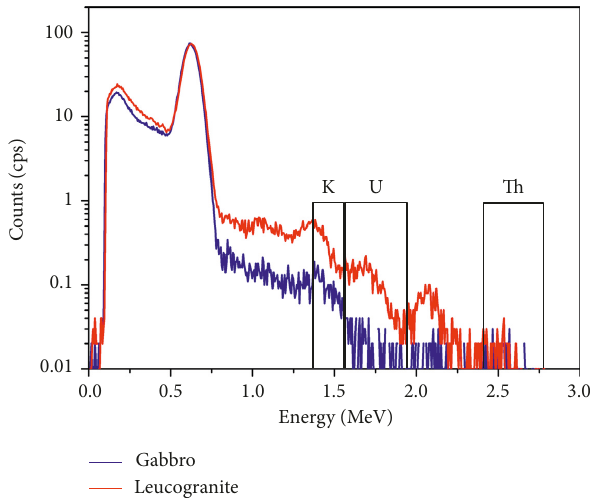
Figure 2: Example of two different field gamma spectrometry (FGS) spectra acquired on outcrops of gabbro (blue) and leu- cogranite (red) with indication of the energy windows for element